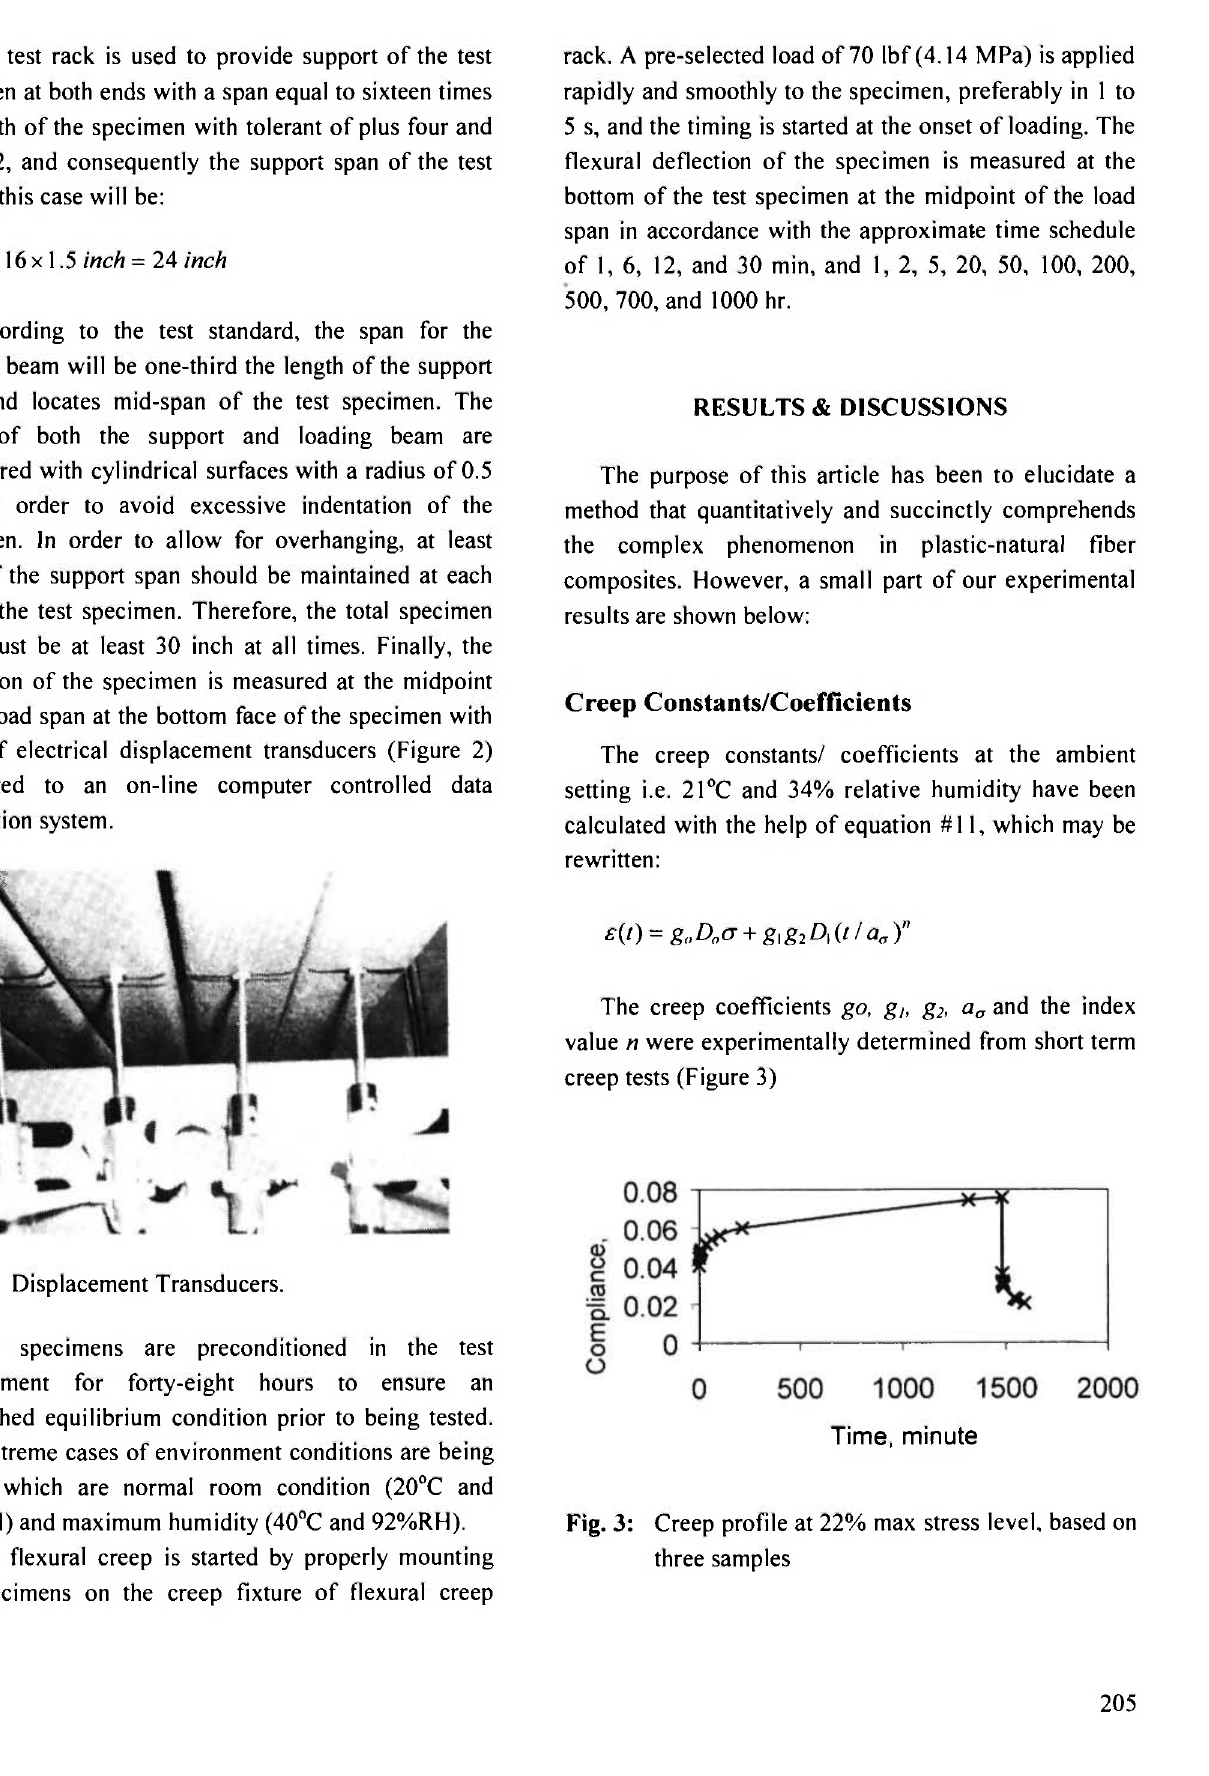
Fig. 2: Displacement Transducers.